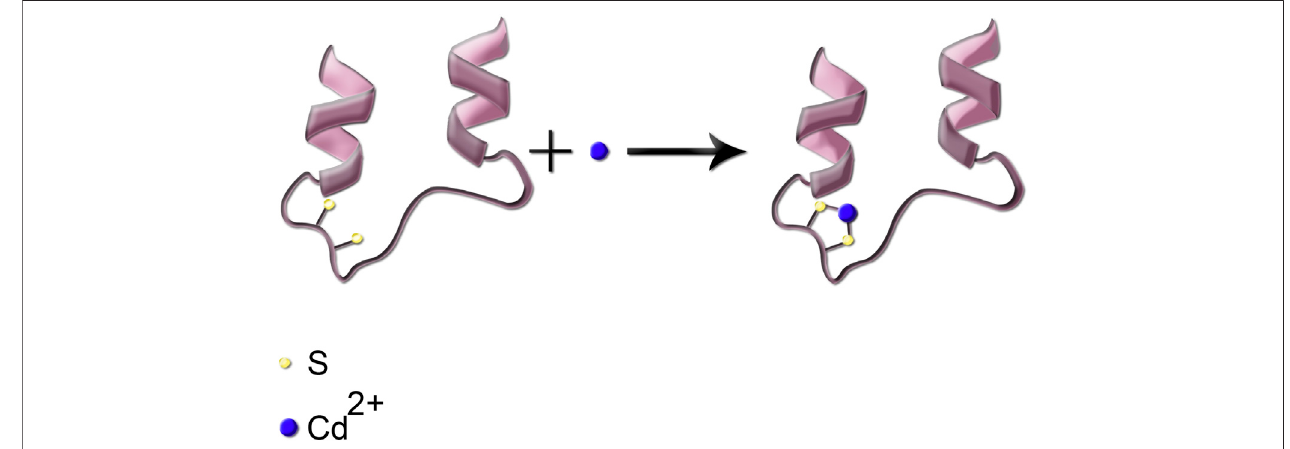
FIGURE 3 | Simpli fi ed schematic presentation of the reaction of Cd metal ion with the thiol functional group; the two sulfhydryl groups are shown in cream color.